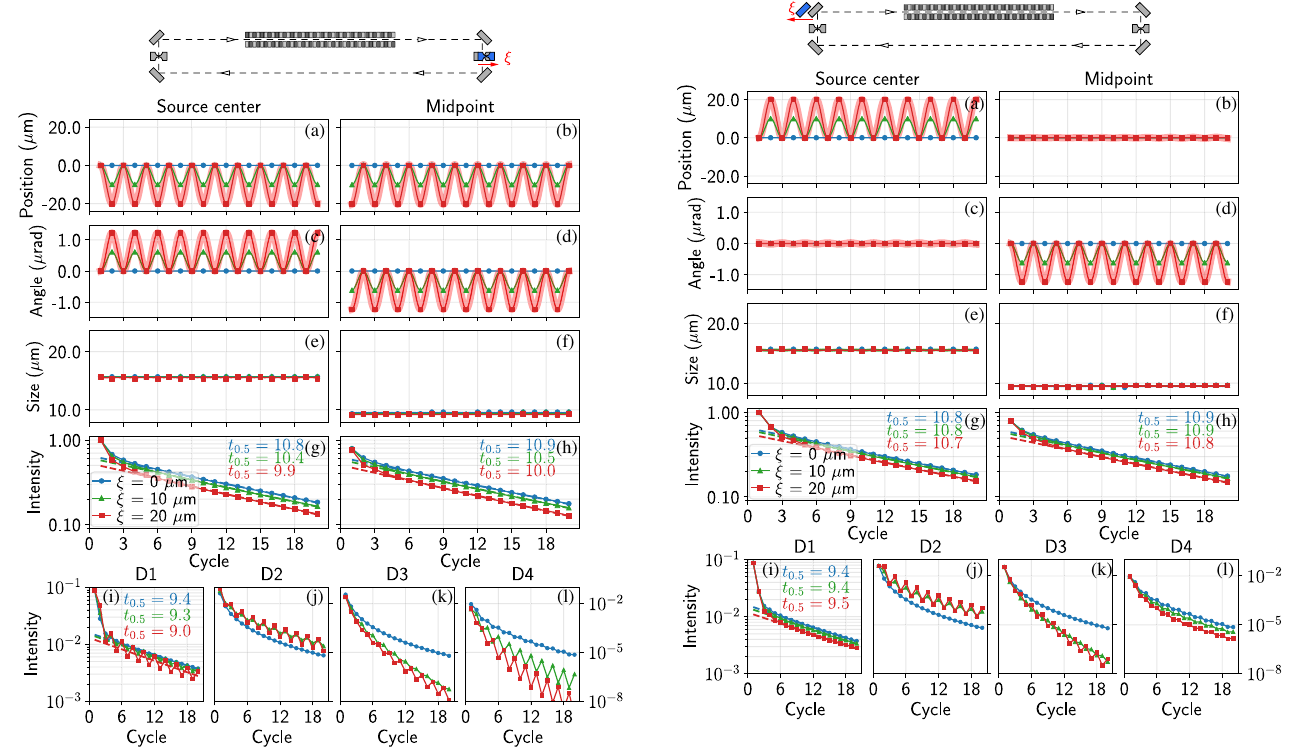
FIG. 23. Similar to Fig. 21, but with position error ξ at lens L 1 .